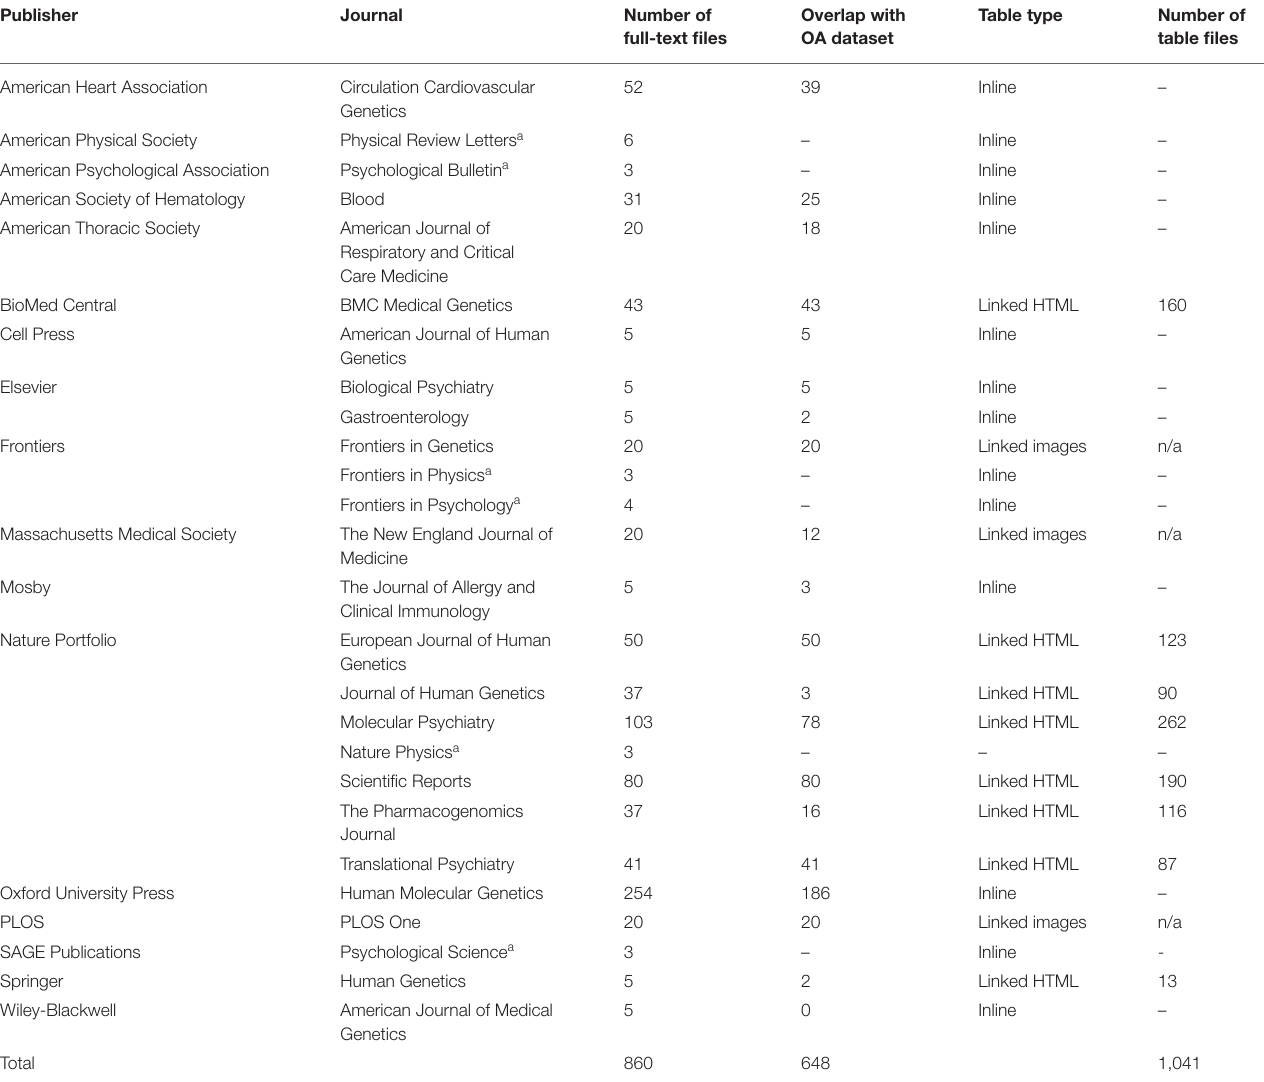
TABLE 1 | Publishers and journals included in the publisher